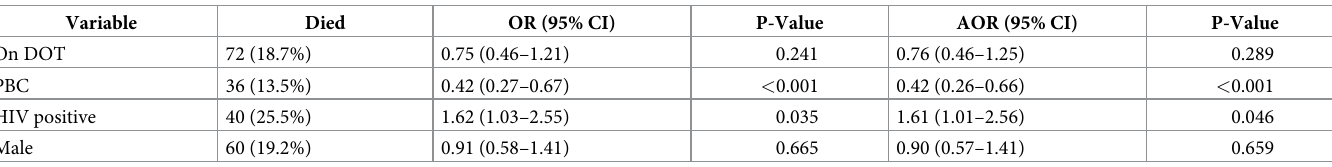
Table 7. Risk factors associated with death among the elderly TB